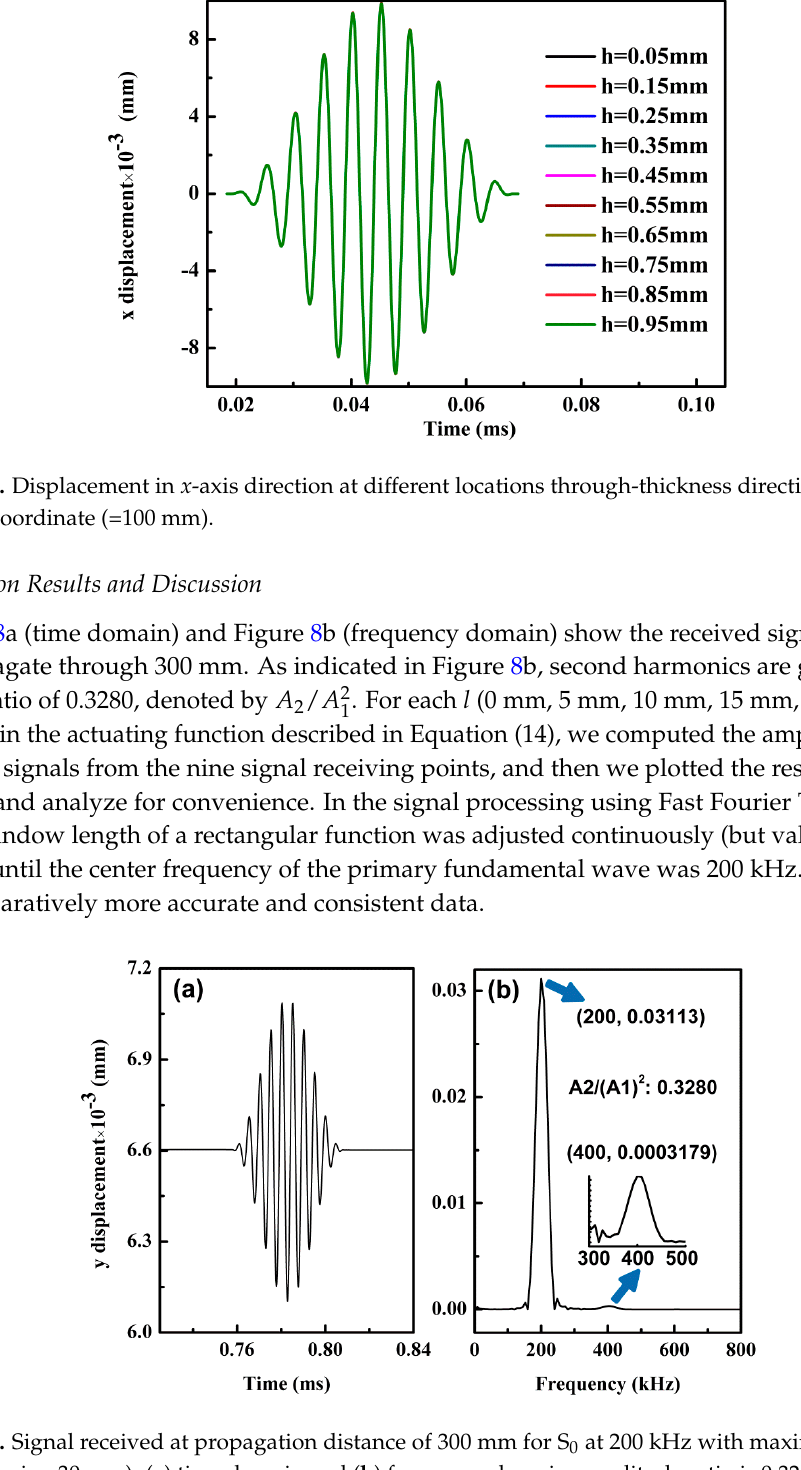
Figure 8. Signal received at propagation distance of 300 mm for S 0 at 200 kHz with maximum strain 0.015 (tension 30 mm): ( a ) time domain and ( b ) frequency domain; amplitude ratio is 0.3280.